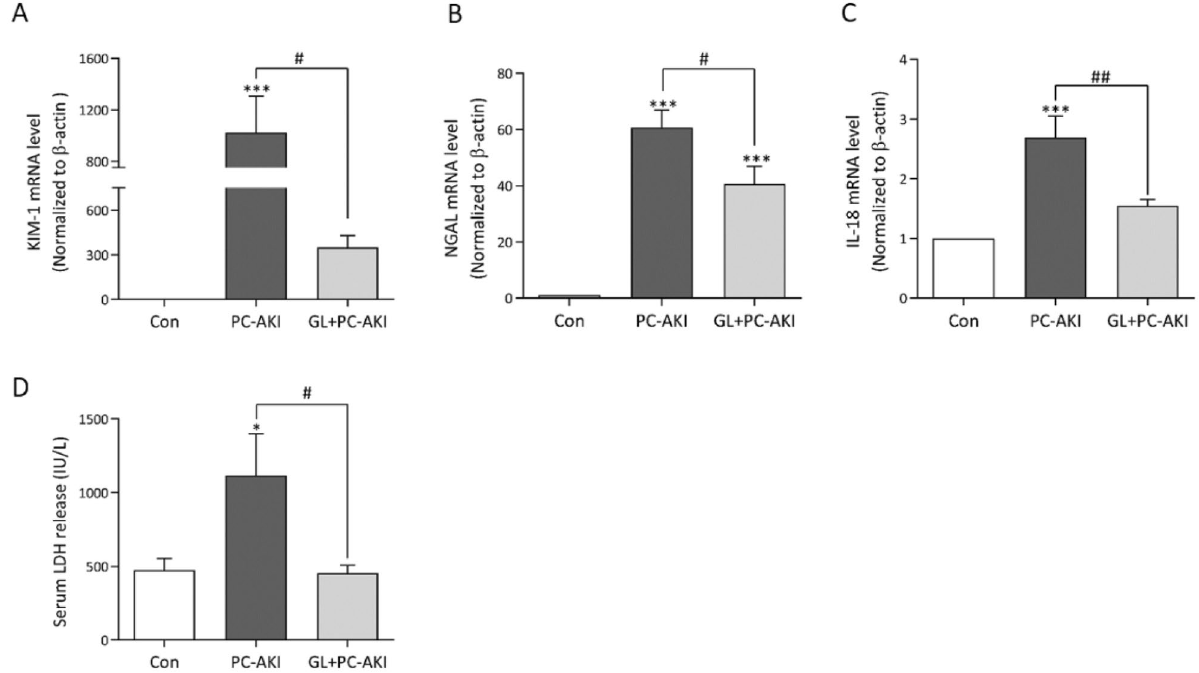
Figure 4. Effect of glycyrrhizin on the mRNA expression of kidney injury markers and serum lactate dehydrogenase (LDH). (A-C) Relative expressions of KIM-1, NGAL and IL-18 mRNA were measured using RT-PCR. The mRNA expression of kidney injury markers was significantly higher in the PC-AKI group compared to the controls, whereas it was significantly lower in the PC-AKI with glycyrrhizin group. (D) Compared to the control group, serum LDH levels significantly increased in PC-AKI, whereas they decreased with glycyrrhizin pretreatment. Results were expressed as means ± SEMs. N = 8 for each group. Statistical significance: * P < 0.05 and *** P < 0.001 Con vs PC-AKI and Con vs PC-AKI + GL, # P < 0.05 and ## P <